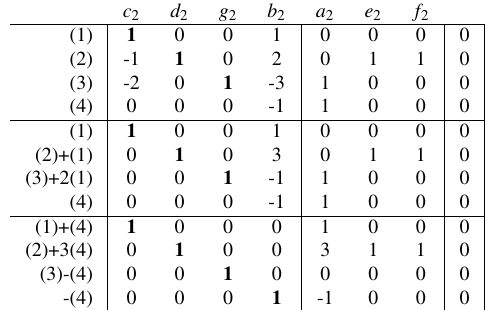
Table 3. Application of Gauss-Jordan elimination in the DA for the PD